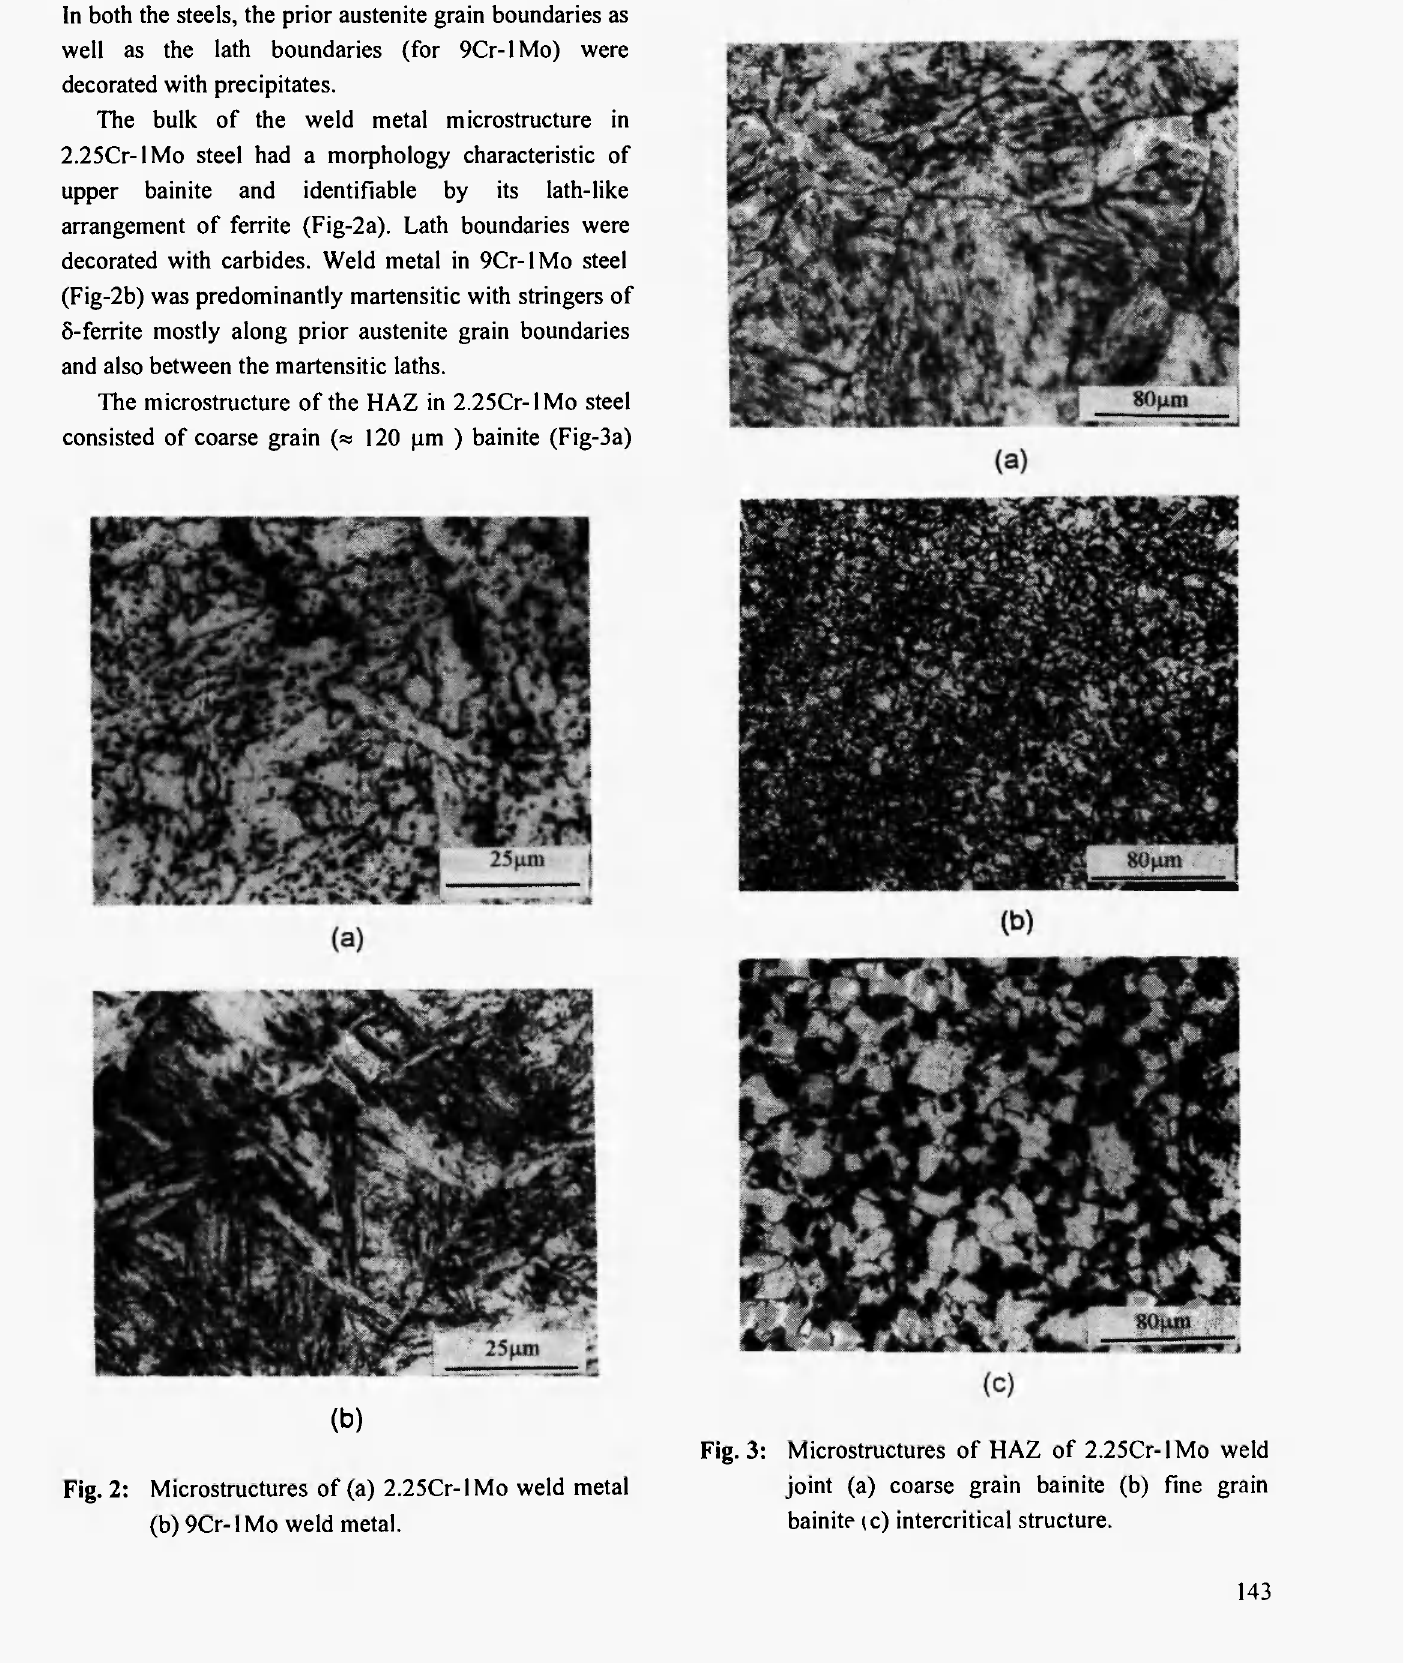
Fig. 3: Microstructures of HAZ of 2.25Cr-lMo weld joint (a) coarse grain bainite (b) fine grain bainite (c) intercritical